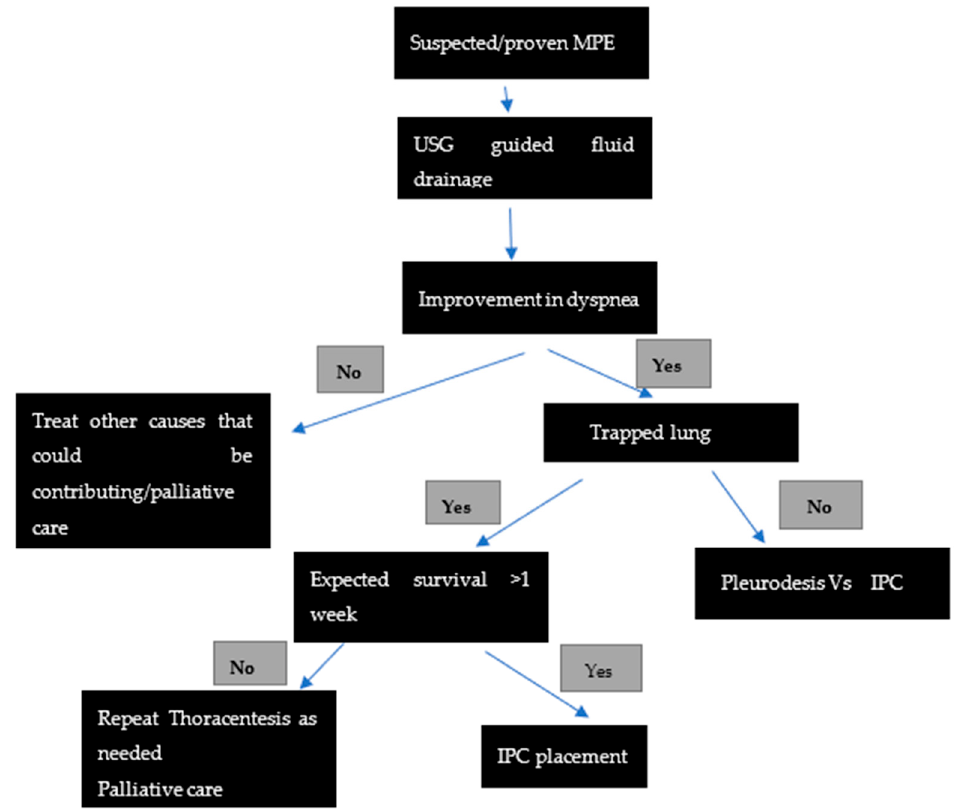
Figure 1. Algorithm suggested for the management of suspected/proven recurrent malignant pleural effusion.